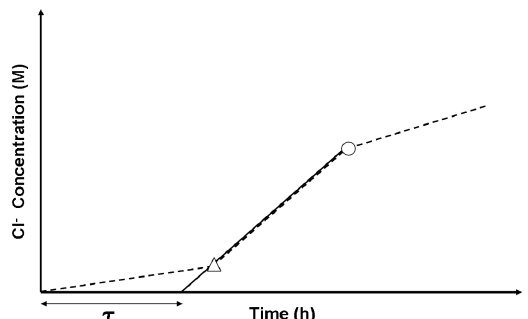
Figure 4. Experimental determination of the time lag (τ); onset (Δ) and end (○) of the steady -state diffusion stage (adapted from Castellote et al.